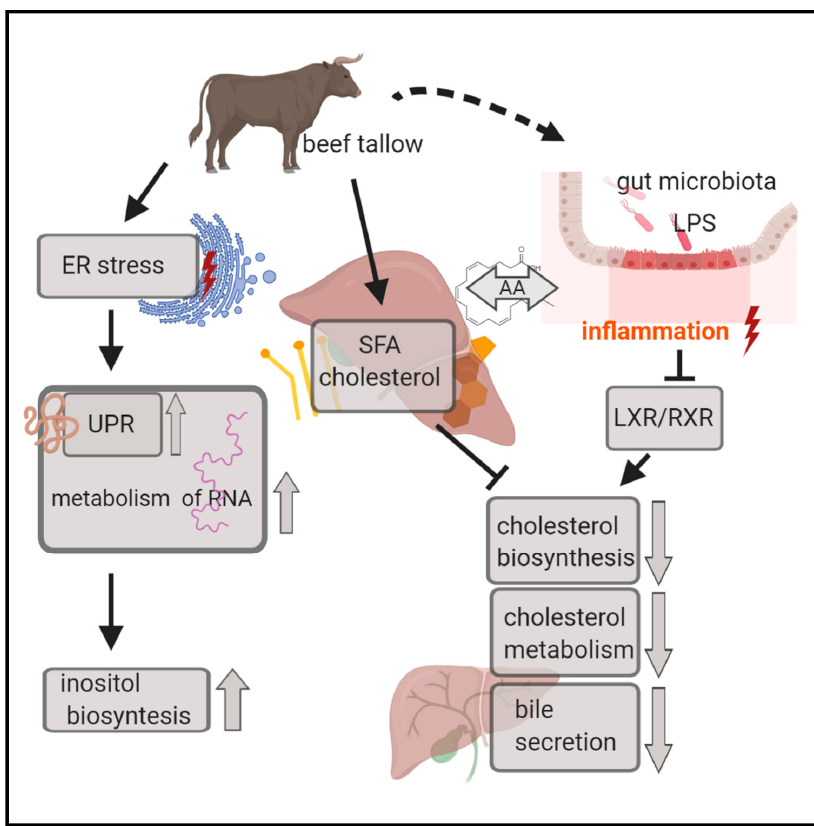
Figure 8. Graphical illustration of selected biological processes and canonical pathways altered in the beef tallow group when compared to rapeseed oil. Beef tallow contains pro-inflammatory ingredients (SFA, AA—arachidonic acid) that could change gut microbiota and promote inflammation. SFA and cholesterol from beef tallow decrease cholesterol biosynthesis directly in the liver and indirectly through inhibition of LXR/RXR by LPS/IL-1.